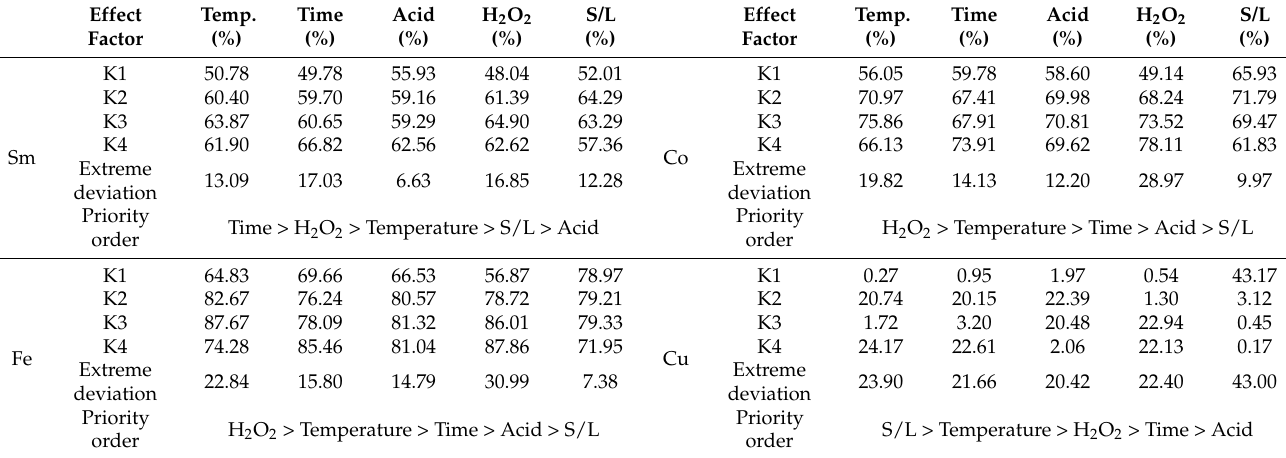
Table 5. Factor response table for citric acid.